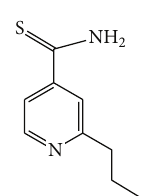
Figure 1: The chemical structure of protionamide.